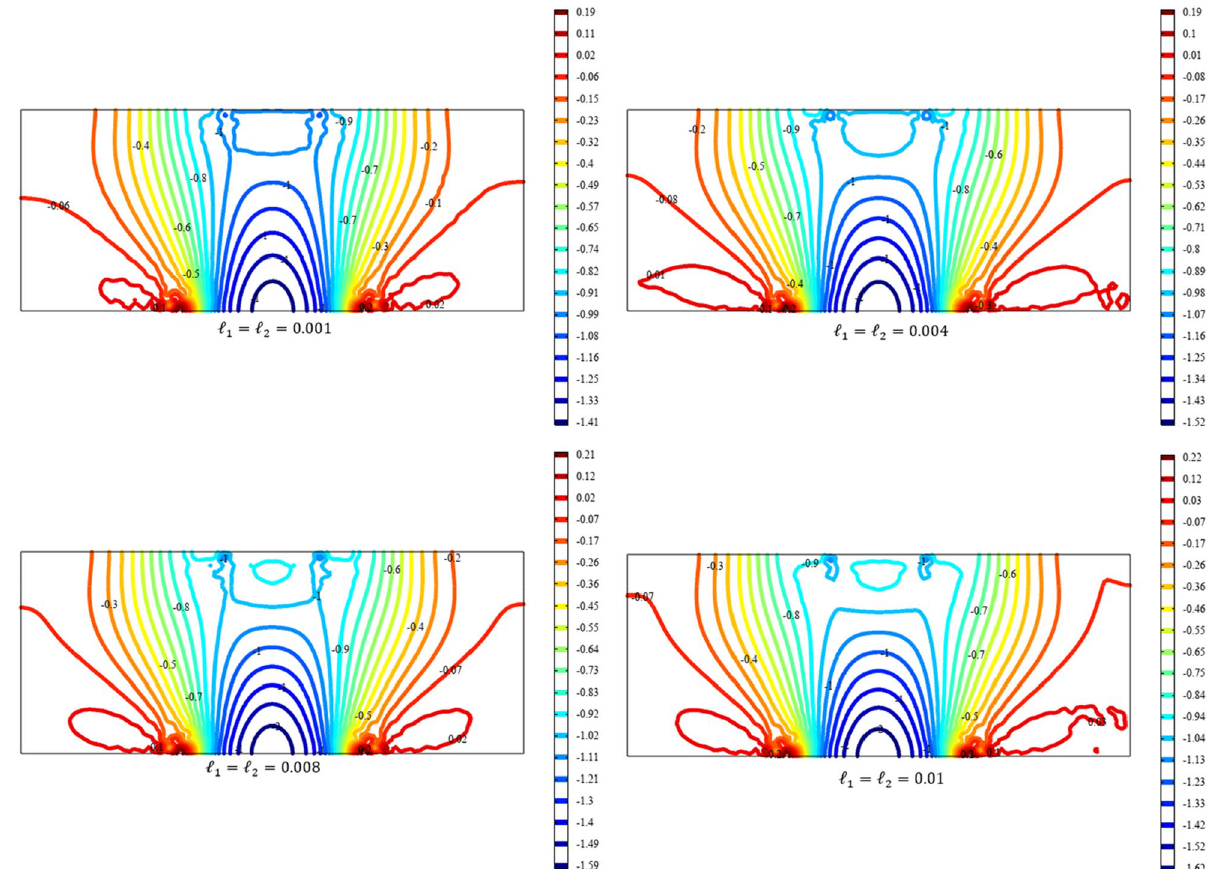
/ | u 0 | for different values of ℓ 1 and ℓ 2 (COMSOL (cid:30)